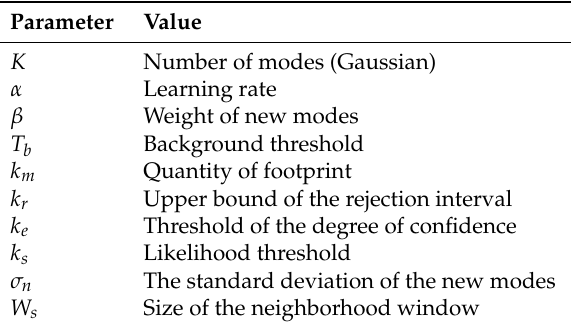
Table 3. Parameters of the